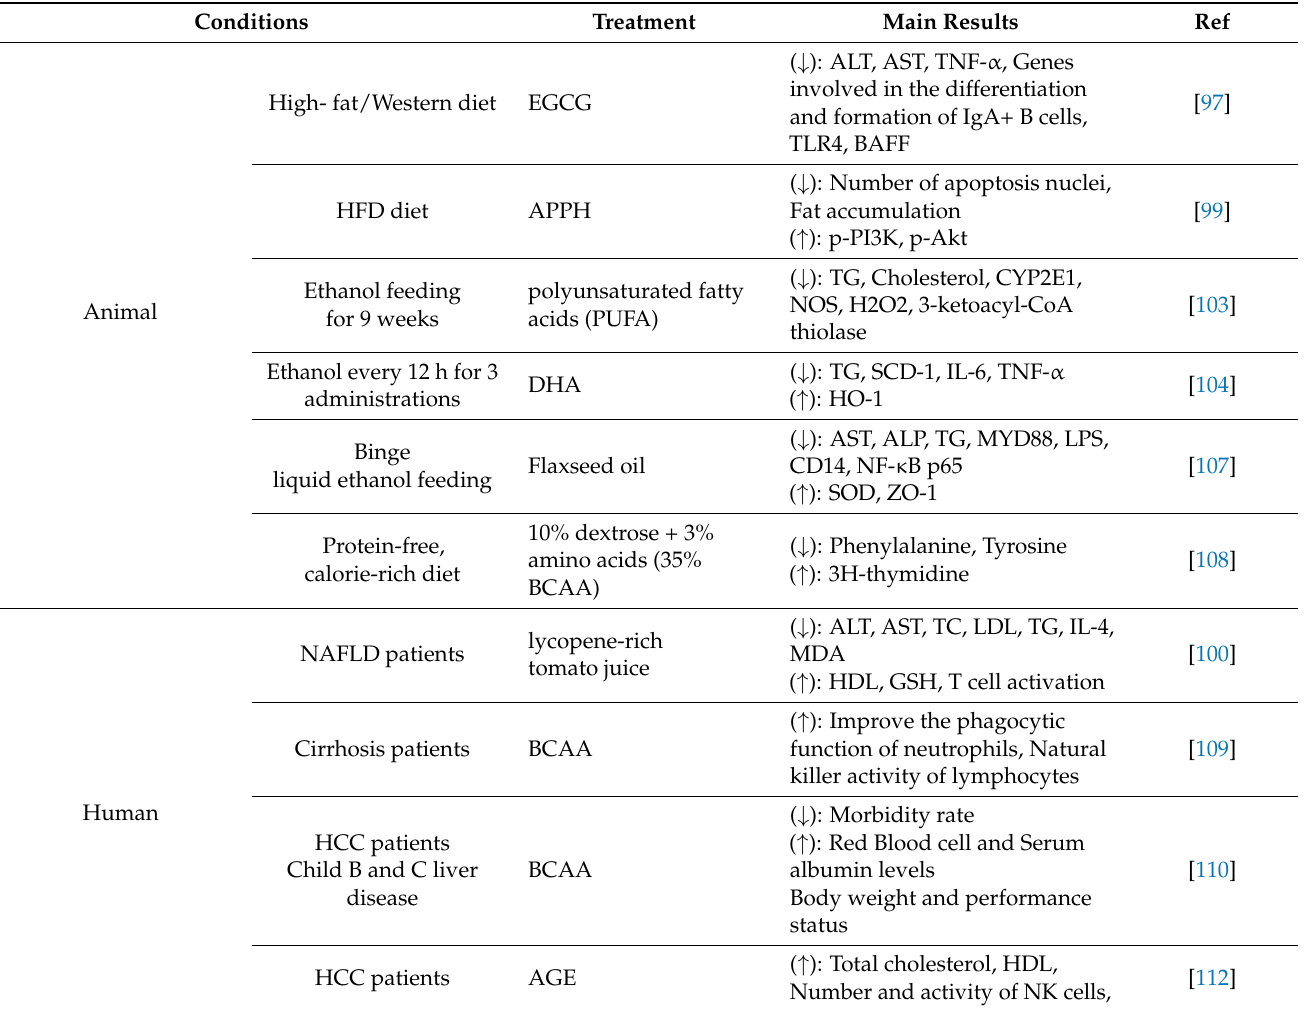
Table 5. Animal and human studies using diet in liver